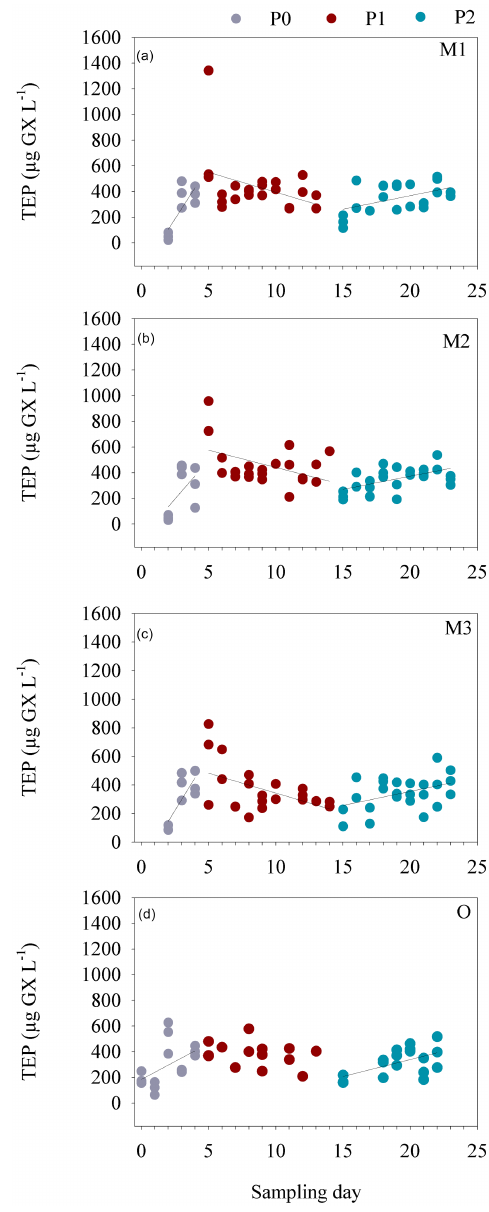
Figure 1. Temporal changes in transparent exopolymeric parti- cle (TEP) concentrations (µgGXL − 1 ) during the VAHINE meso- cosm experiment. Data shown are from daily sampling of three depths (1, 6, 12m) in each mesocosm. Data were analyzed accord- ing to the characterized phases of the experiment based on the di- azotrophic communities that developed in the mesocosms (Turk- Kubo et al., 2015) and biogeochemical characteristics (Bonnet et al., 2016a). (a) Mesocosm 1 (M1), (b) Mesocosm 2 (M2), (c) Meso- cosm 3 (M3), (d) samples from the lagoon waters outside of the mesocosms (O). Phases: P0 denotes days 2–4, P1 denotes days 5– 14, P2 denotes days 15–23. Linear regressions (Pearson) of TEP for each of the phases are designated by a solid line, only when significant. Pearson correlation coefficients and significant values ( p < 0.05) are represented in bold in Table